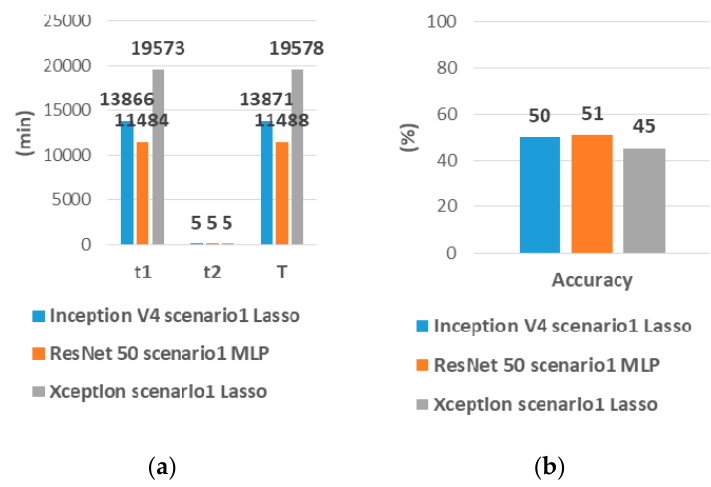
Figure 5. ( a ) Training data collection time t 1 , training time t 2 , and total time T of scenario 2, ( b ) For each CNN model, the highest processing prediction accuracy of scenario 2.